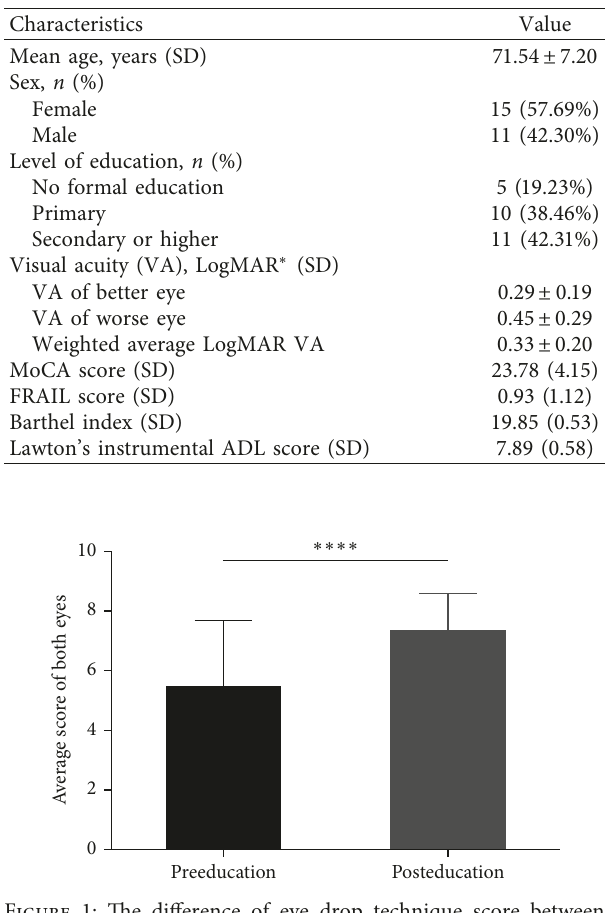
; p 0 . 0001; paired t - ∗∗∗∗ <